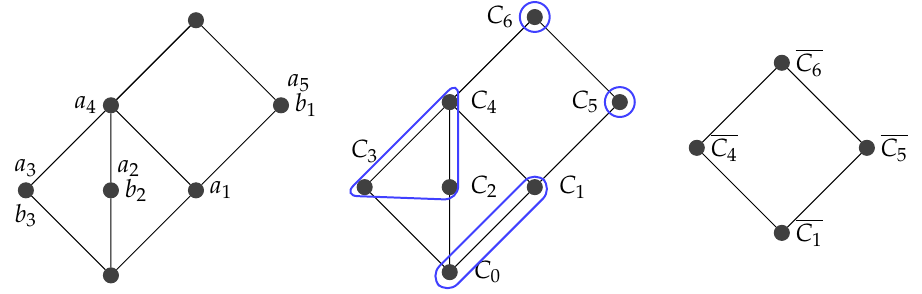
Figure 2. Concept lattices of Example